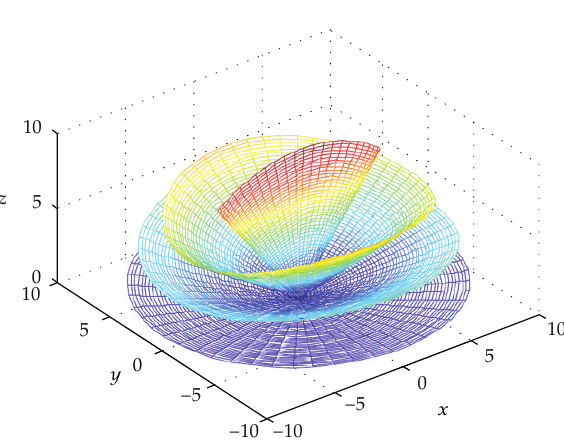
Figure 5: Influence of the parameter μ on the shape of the